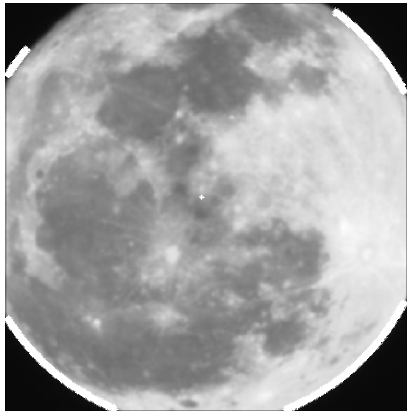
Figure 11. Example 1: Circular Sigmoid Function (CSF)-LS final estimation. Center (white mark) inside the image. Row center: 186.169 pixel ( ∆ r = − 0 . 71781 ). Column center: 187.8695 pixel ( ∆ c = − 0 . 53055 ). Radius: 217.6452 pixel ( ∆ R = 0 . 38853